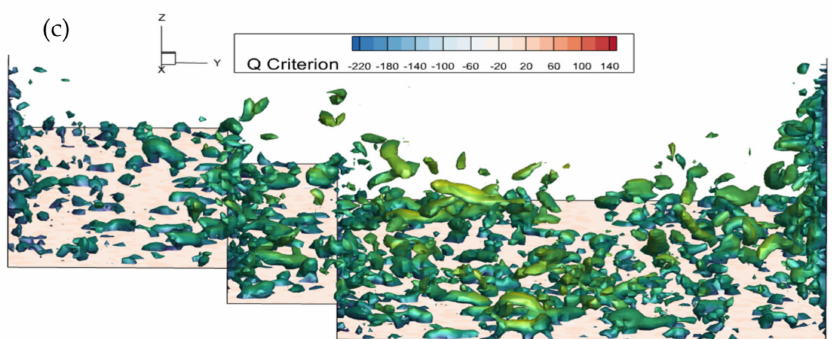
Figure 8. Instantaneous vortical structure plotted as iso-surfaces of λ 2 = − 20 for Dr at ( a ) 0.1, ( b ) 0.3 and ( c ) 0.5, respectively, and coloured by the x-velocity component in the multistage compound open-channel